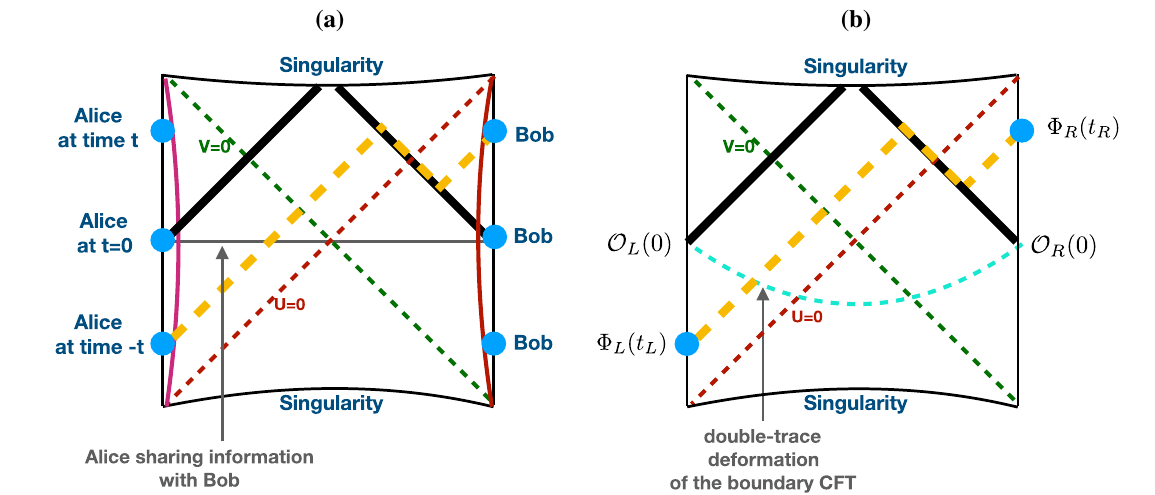
Fig. 4 In a , Alice sends a signal at time − t , (shown by yellow dashes) then she measures a part of the Hawking radiation and exchanges infor- mation with Bob at time t = 0 (shown with gray line). This helps Bob send a negative energy shock (shown with solid black). Because of this, the signal reaches Bob at time t due to a Shapiro time advance. This is the essence of quantum teleportation [84,141,142]. In b , following